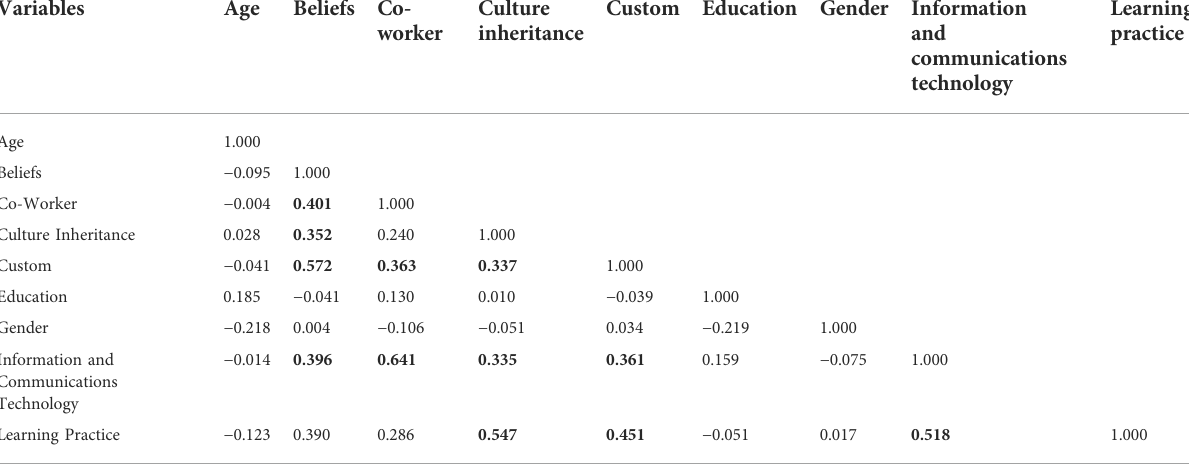
TABLE 6 Correlation among variable. Bold Values indicate moderate to high correlation among